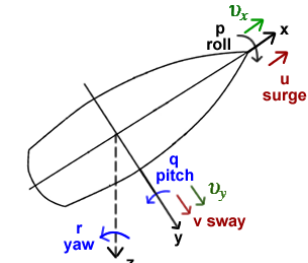
Figure 2. Boat coordinate frame ( υ x , υ y ) and the apparent water velocity